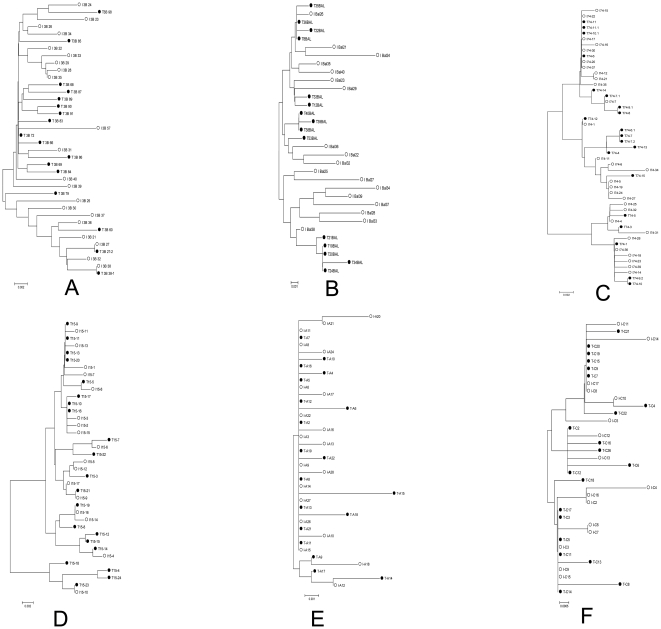
Neighbor-joining trees of HIV-1 env C2-V5 sequences individually from six inoculum and transmission pairs.Aligned nucleotide sequences for six inoculums and transmitted variants were used to generate neighbor-joining trees for individual viral pairs. (A) HIV-1 subtype B, IIIB; (B) HIV-1 subtype B, BAL; (C) HIV-1 subtype B, clinical isolate 074; (D) HIV-1 subtype B, clinical isolate 015; (E) HIV-1 subtype A, RW92008; (F) HIV-1 subtype C, IN93999. White circles: the sequences of the inoculum viruses; black circles: the sequences of the transmitted viruses.